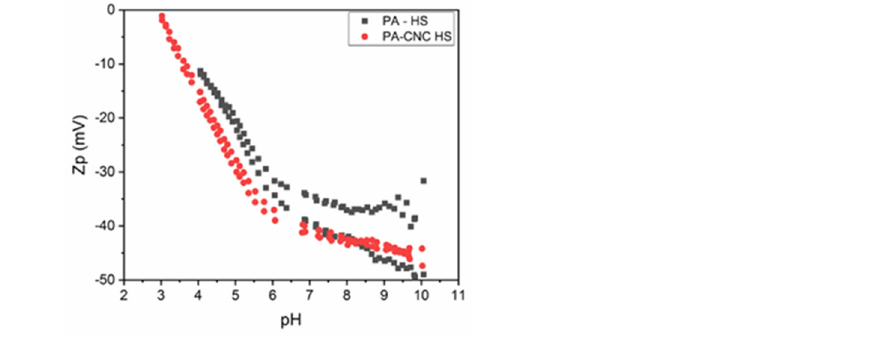
Figure 1. Zeta potential for both the modified (PA-CNC) and the unmodified (PA) membranes.